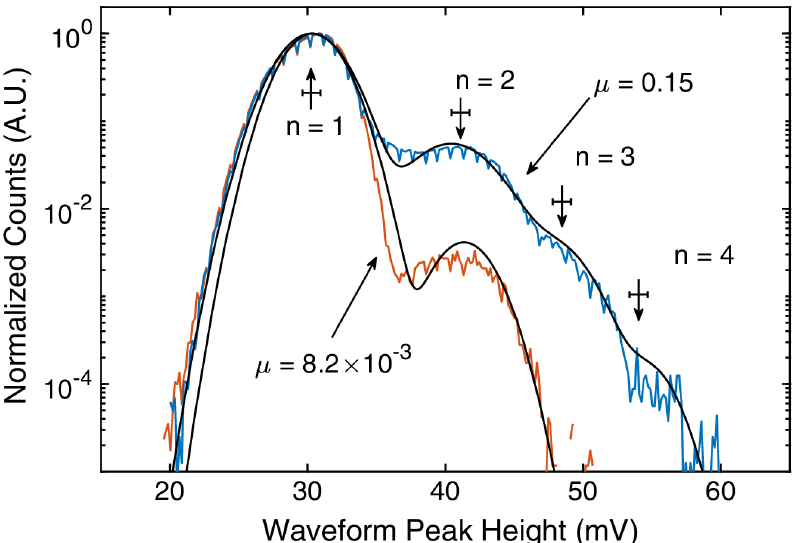
Figure 2. Histograms of the peak height of differentiated detection waveforms corresponding to detection of n -photon signal. The two curves correspond to light wave packets with different mean detected photon number µ . The arrows with corresponding error bars show predicted values of the peaks from the electro-thermal model and finite-bandwidth amplifiers. Figure reproduced from Cahal, et al., Optica 4 , 1534–1535 (2017) [108].